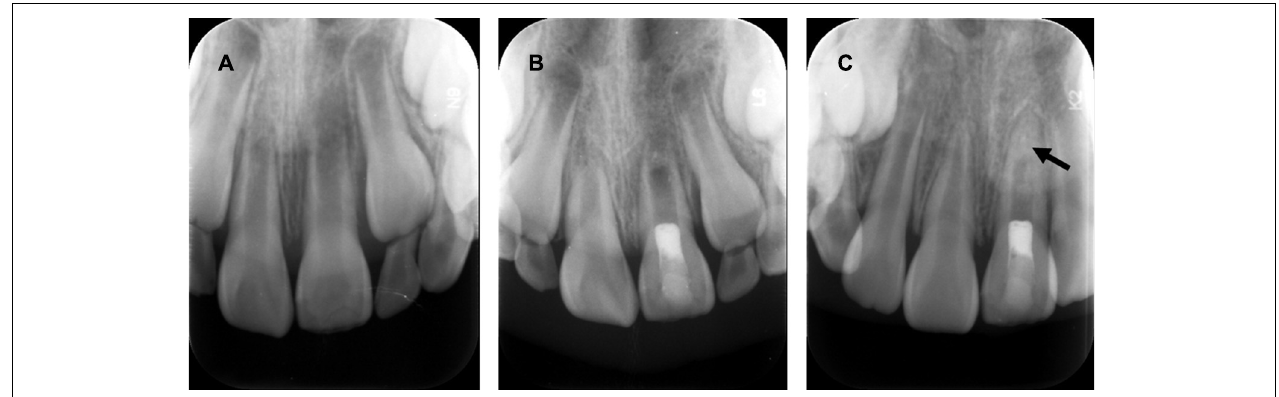
FIGURE 3 | Revascularization promotes continued root development and resolution of periapical lesion, but disorganized radio-opaque changes occur within the apical root canal. (A) Radiograph of a maxillary left central incisor: immature root formation with a wide-open apex and periapical lesion. (B) Postoperative radiograph of revascularization and coronal restoration. (C) Radiograph of one-year follow-up: resolution of periapical lesion and root apex closure. Arrow: non-specific radio-opaque calcific deposit within apical root canal. Courtesy of Dr. Xin Zhou.